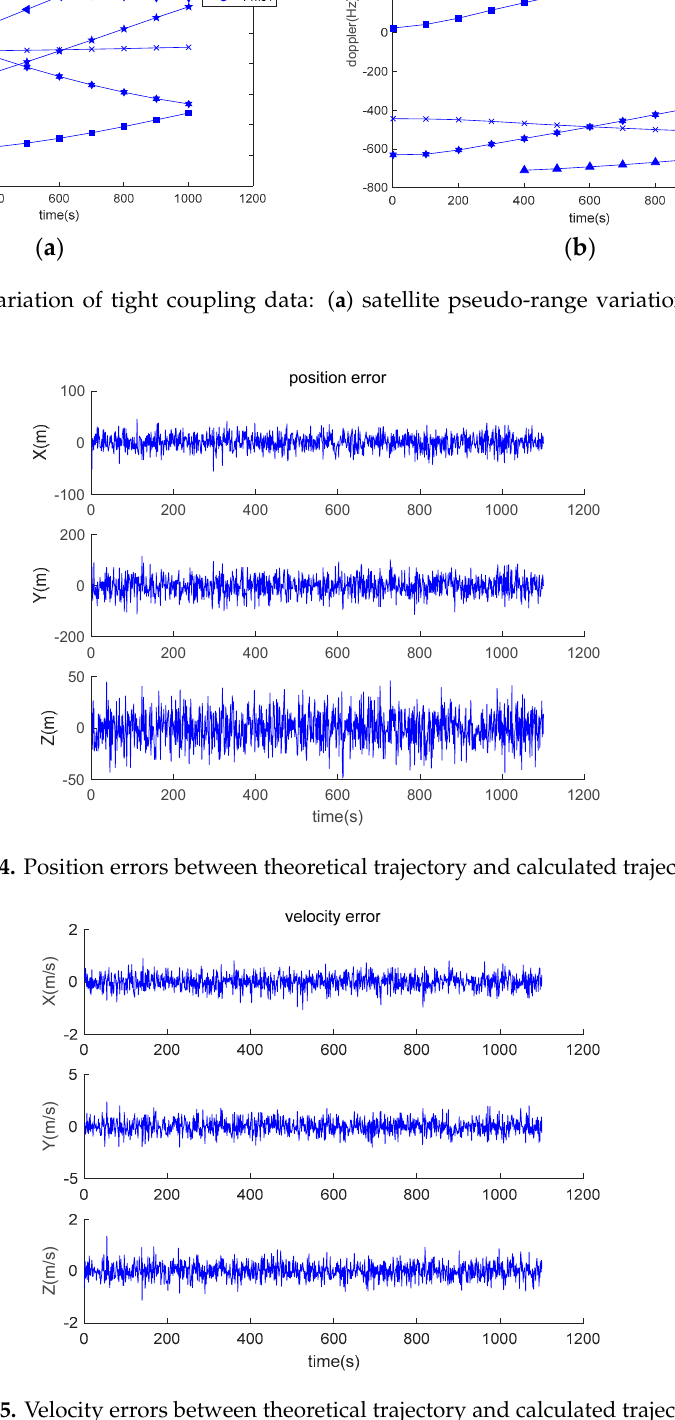
Figure 13. The variation of tight coupling data: ( a ) satellite pseudo-range variation; ( b ) satellite Doppler shift.